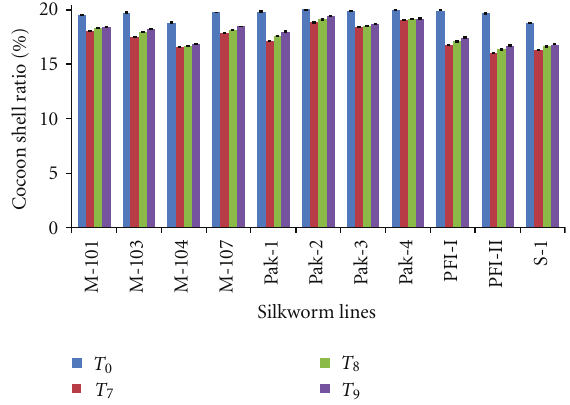
Figure 9: Comparative performance of cocoon shell ratio (mean ± SE) of eleven silkworm lines at 25 ± 1 ◦ C in combination with 55, 65, and 75% RH and controlled conditions of temperature and RH (25 ± 1 ◦ C and 70–80%,